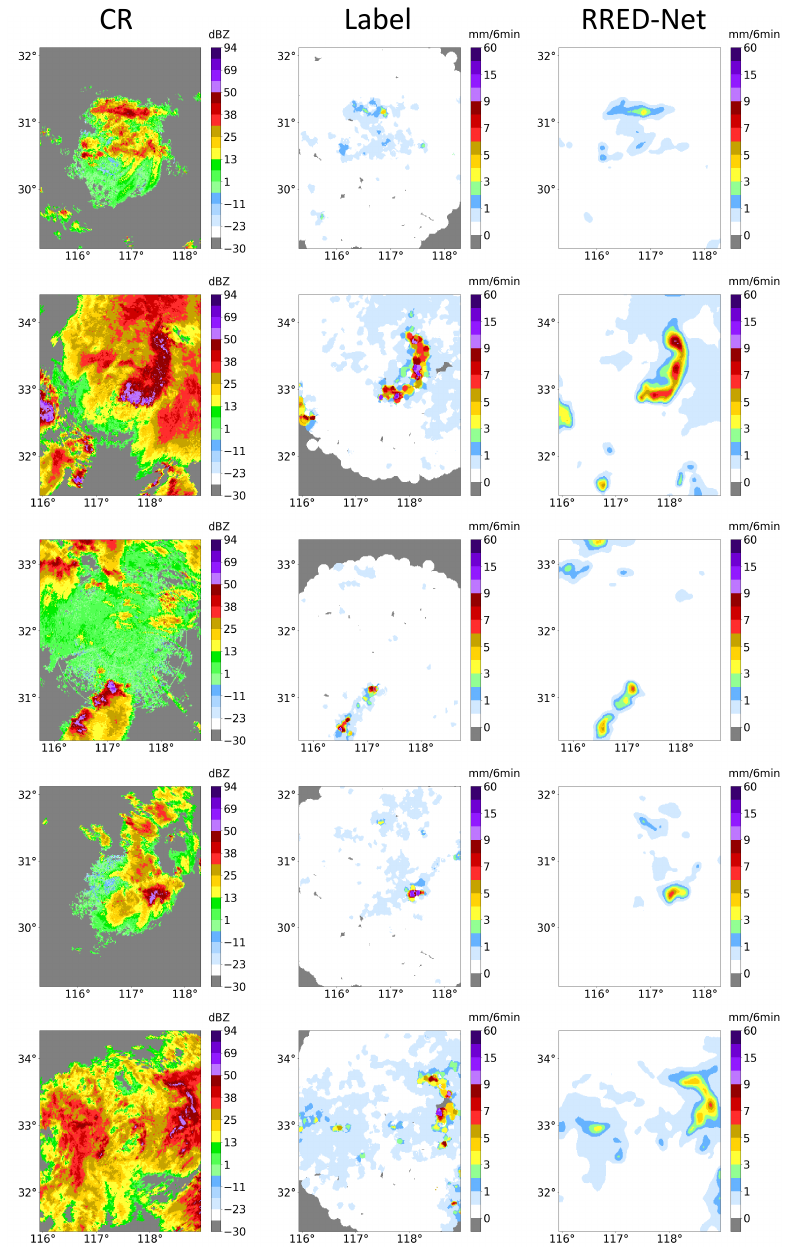
Figure 8. Visualization examples. The precipitation images come from 18:20–18:26 BT (Beijing Time), 2 July 2018; 20:38–20:42 BT, 26 July 2018; 22:43–20:48 BT, 4 July 2018; 09:30–09:36 BT, 26 July 2018; 10:40–10:46 BT, 5 July 2018 from up to down, respectively. CR Doppler radar, predictions of Label, and RRED-Net from left to right,